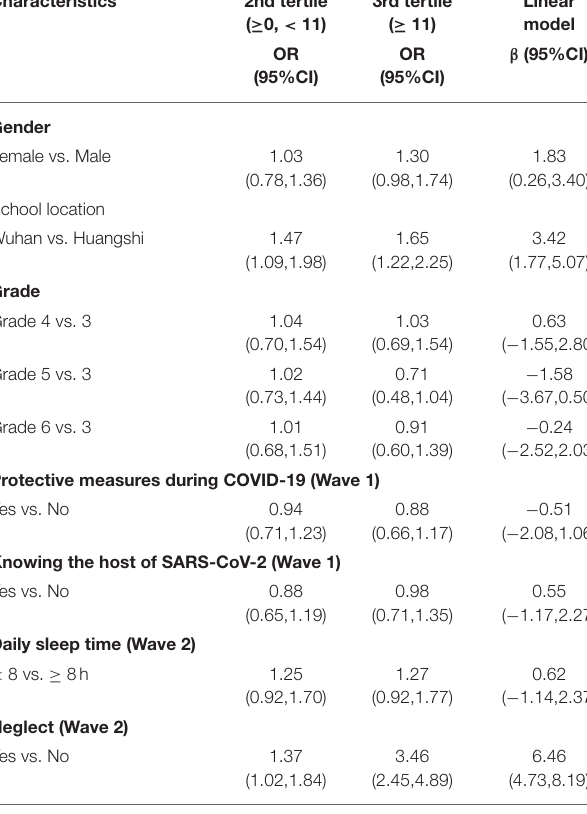
TABLE 4 | Association between demographic characteristics and the difference in Children’s Depression Inventory-short form ( 1 CDI-S) score. Characteristic